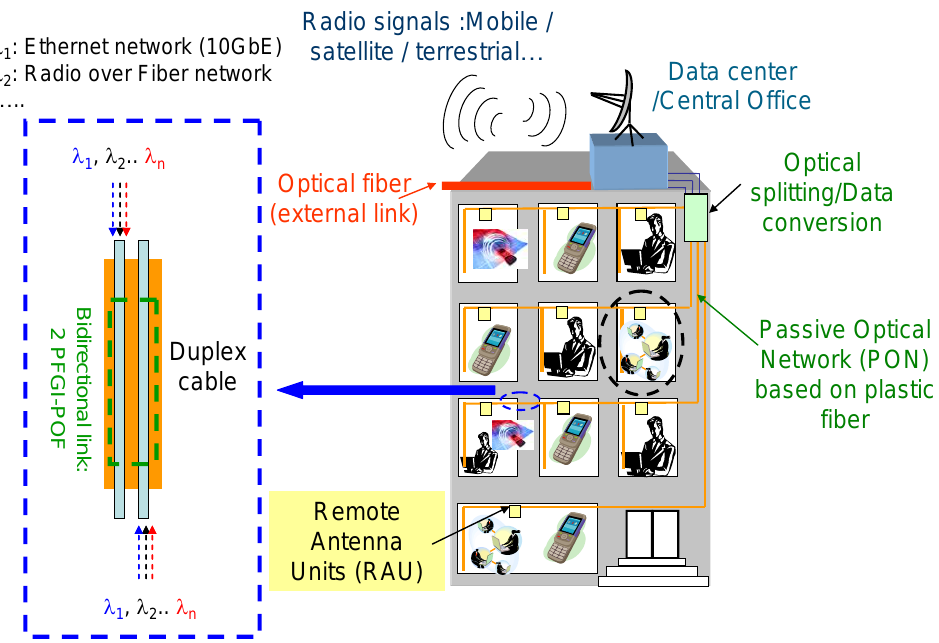
Figure 1. Multi-services concept based on PFGI-POF and deployed inside a